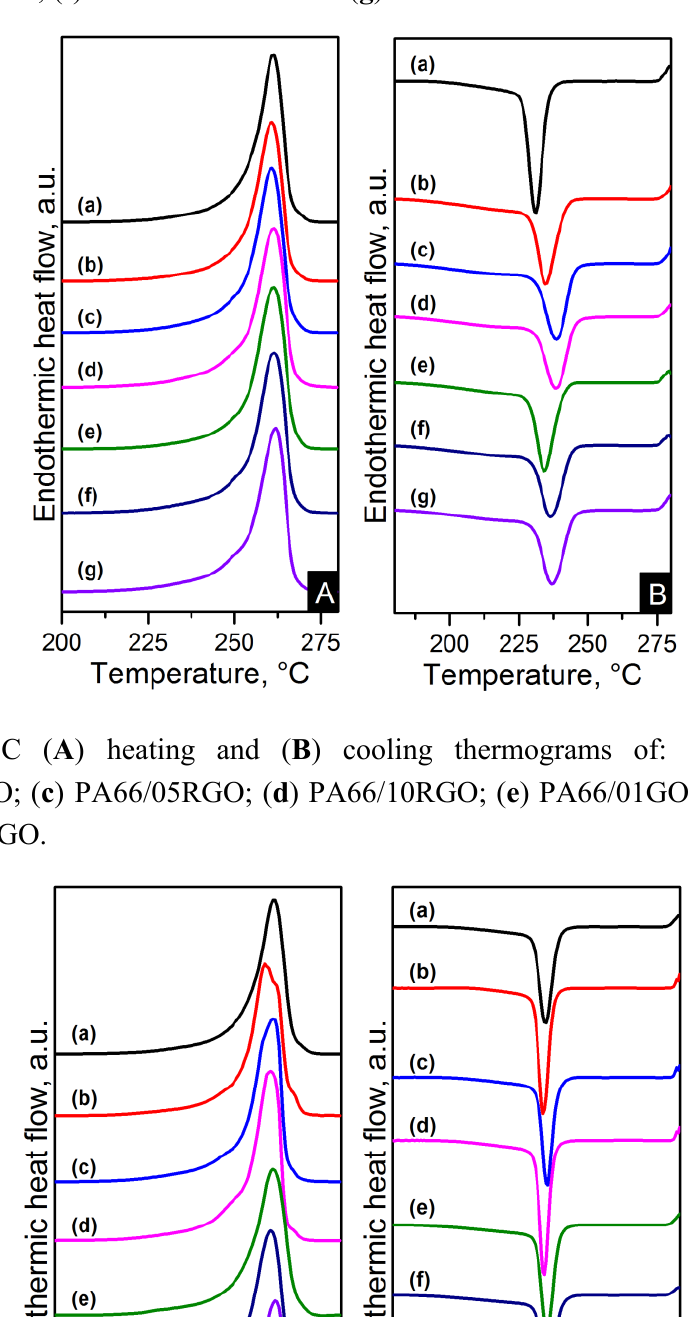
Figure 10. Differential scanning calorimetry (DSC) ( A ) heating and ( B ) cooling thermograms of: ( a ) pure PA66; ( b ) PA66/01CNTs; ( c ) PA66/05CNTs; ( d ) PA66/10CNTs; ( e ) PA66/01OCNTs; ( f ) PA66/05OCNTs and ( g ) PA66/10OCNTs.